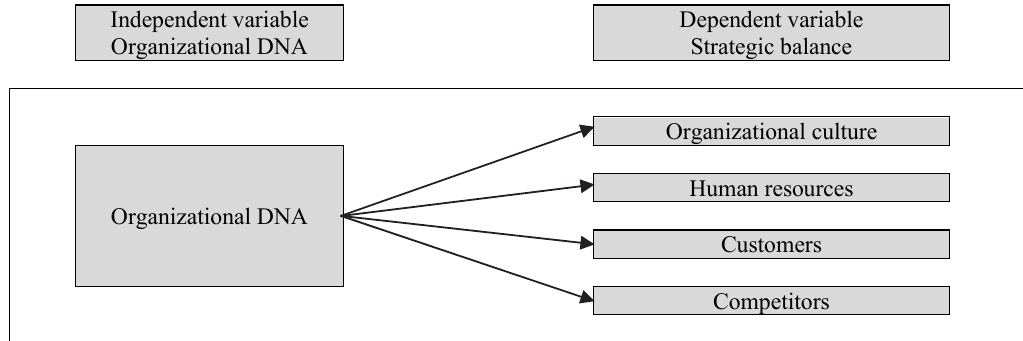
Fig. 1. The Study’s